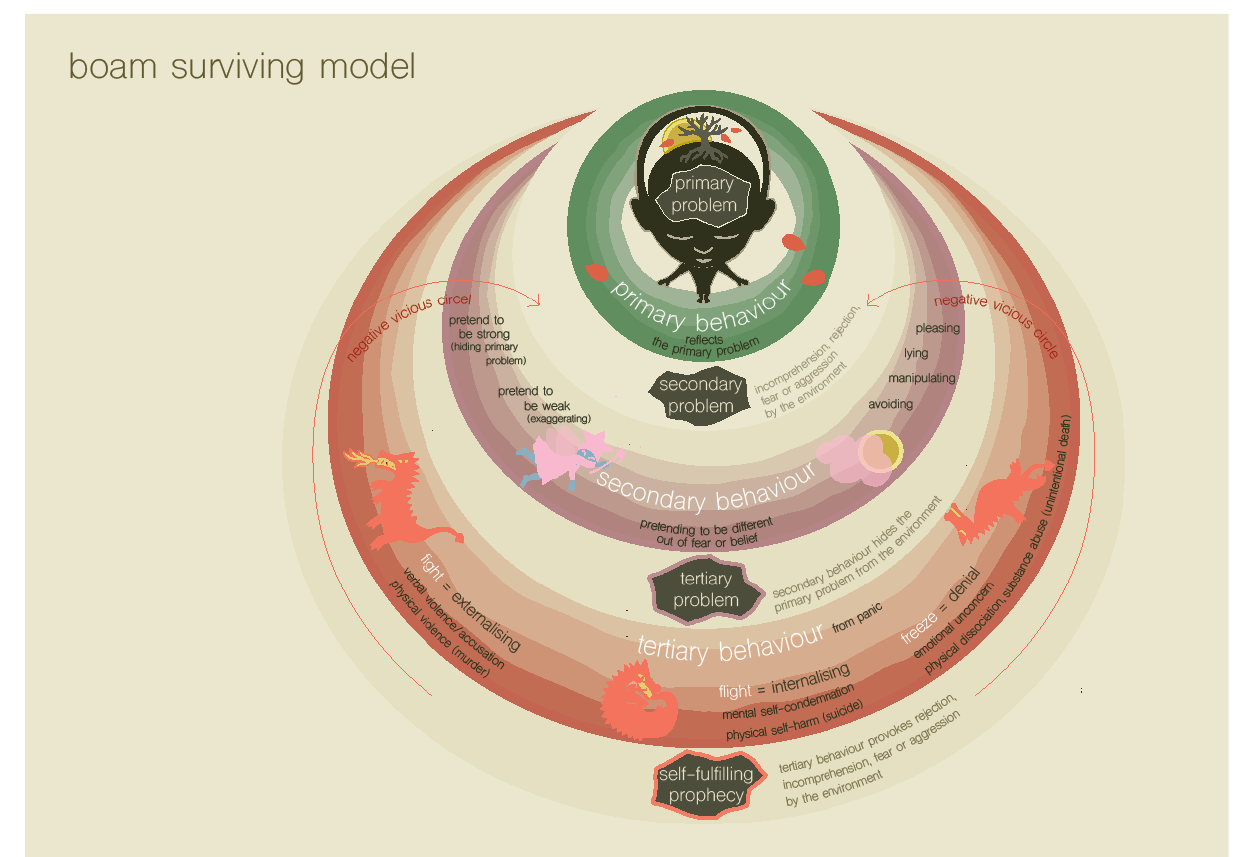
Figure 3. The BOAM surviving model, depicting the consequences of ‘ordering problems’ (Truijens, in